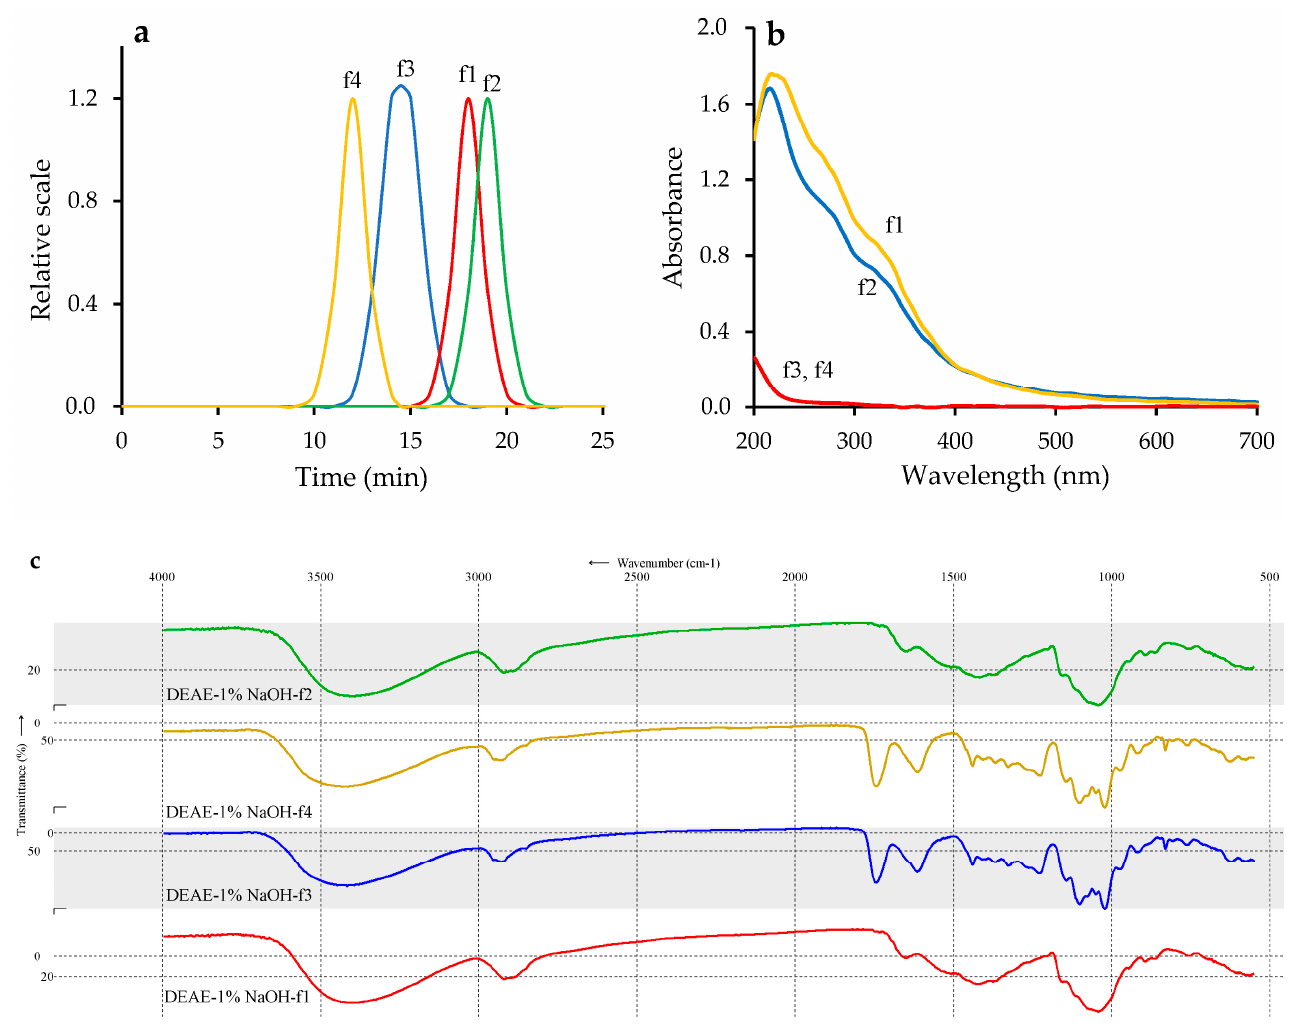
Figure 3. Elution curve of DEAE-1% NaOH fraction on the DEAE – sepharose fast-flow gel.